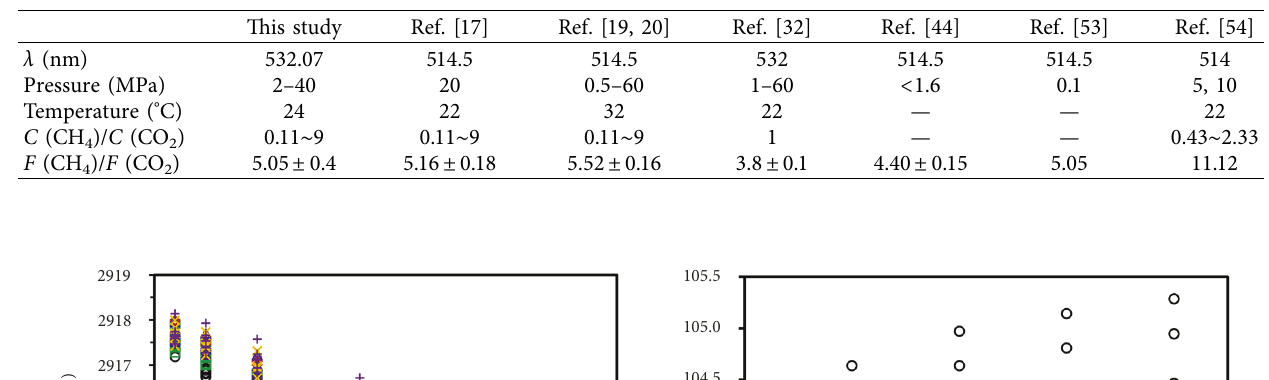
Figure 7: The linear relationship between the molar ratio ( C (CH 4 )/ C (CO 2 )) and the Raman peak area ratio ( A (CH 4 )/ A (CO 2 )) at room temperature. Table 3: Comparison of F (CH 4 )/ F (CO 2 ) in this study with previous